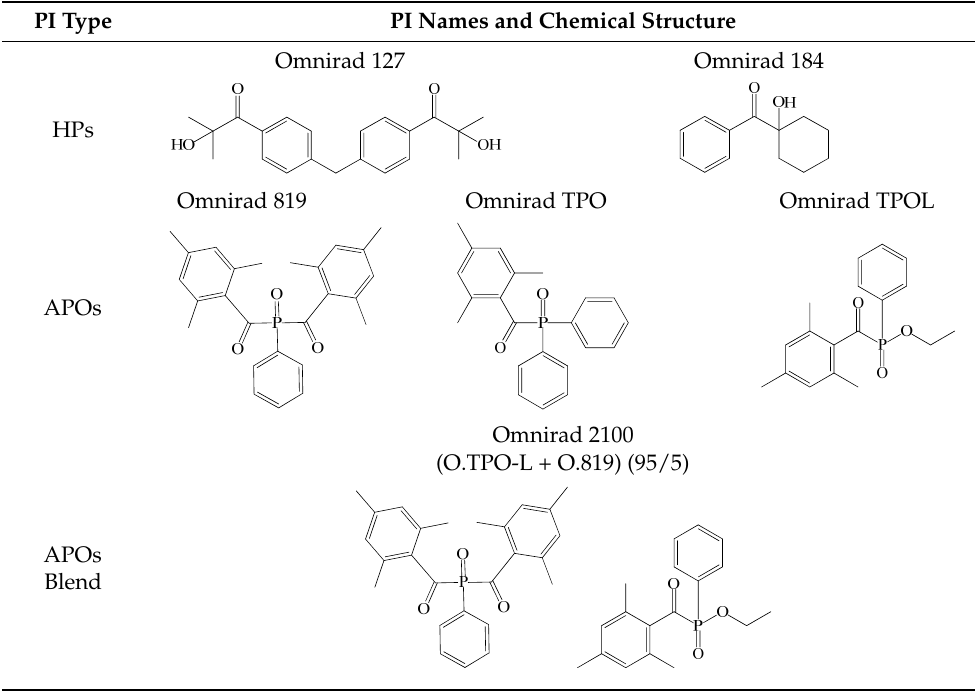
Table 1. Structures of tested photoinitiators.